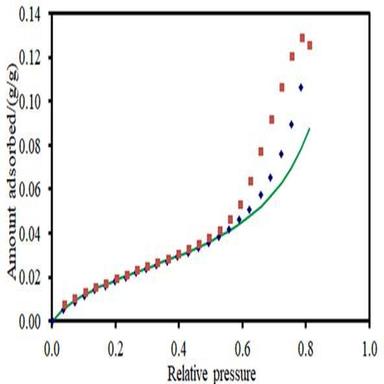
Water adsorption (◆) and desorption (■) isotherms obtained at 283 K. Also shown (solid line) is a fit of the fractal BET isotherm for relative pressures < 0.5.